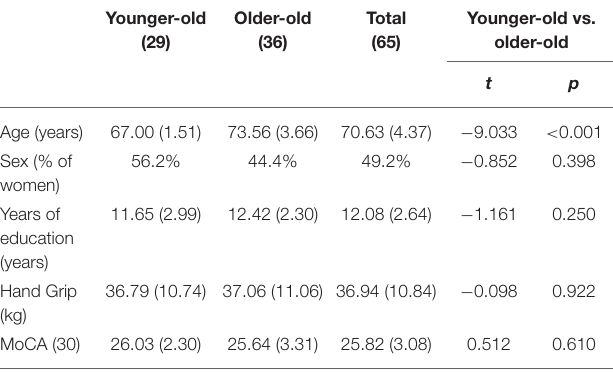
TABLE 1 | The characteristics, cognitive performances, and differences between age groups [presented as mean (SD)] of the